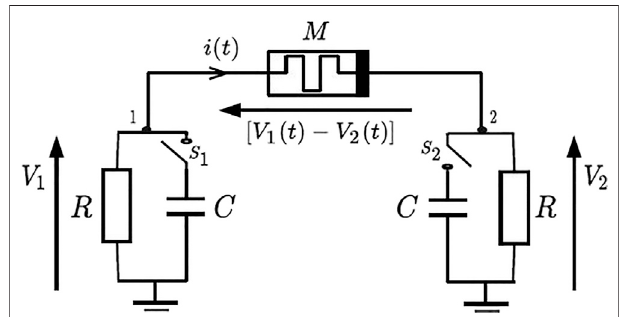
FIGURE 5 | Memristor asymmetry from the circuit point of view: two charged RC cells coupled together by a memristor. The circuit is invoked by the switches S 1 and S 2 . The cells are at different potentials so that the current i ( t ) will fl owthroughthe memristor. Thetest is performed for V 1 > V 2 and then V 1 < V 2 , namely, Cond-1 and Cond-2, respectively. For example V 1 1 V , V